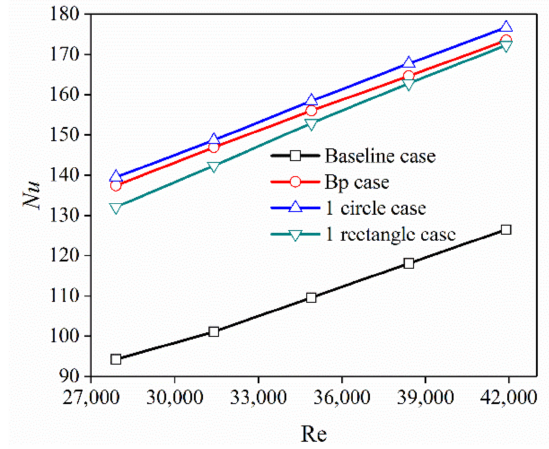
Figure 11. Variation of Nu on the shell side with